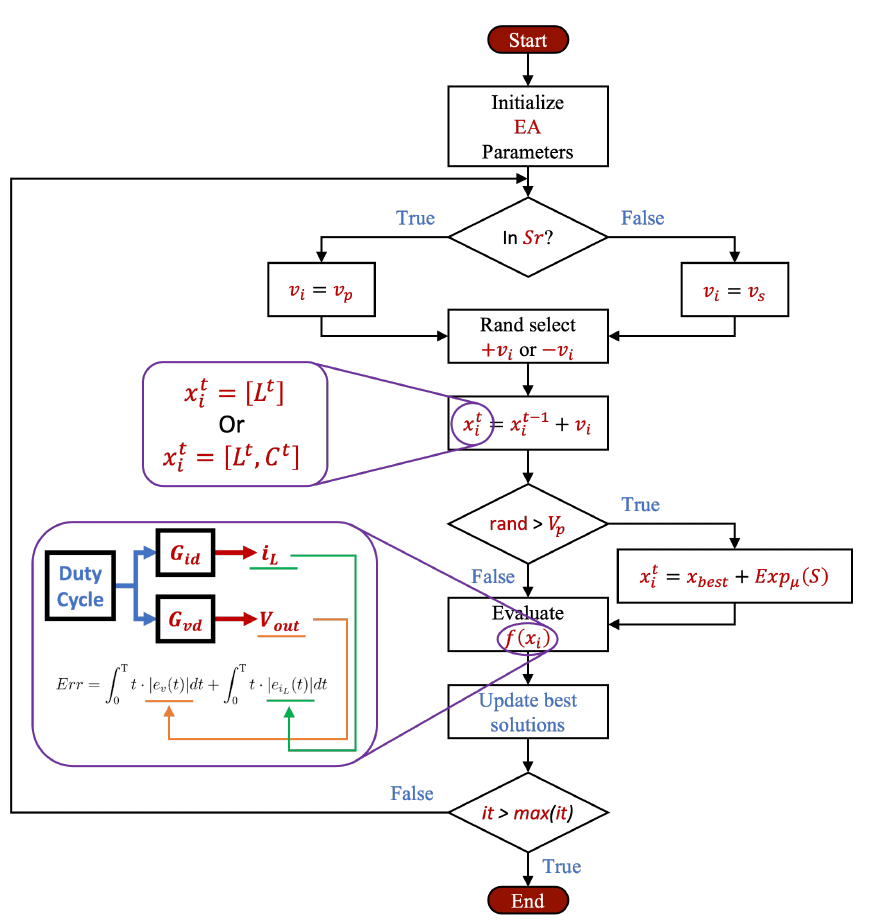
Figure 11. General structure of the earthquake algorithm from the perspective of the optimal design